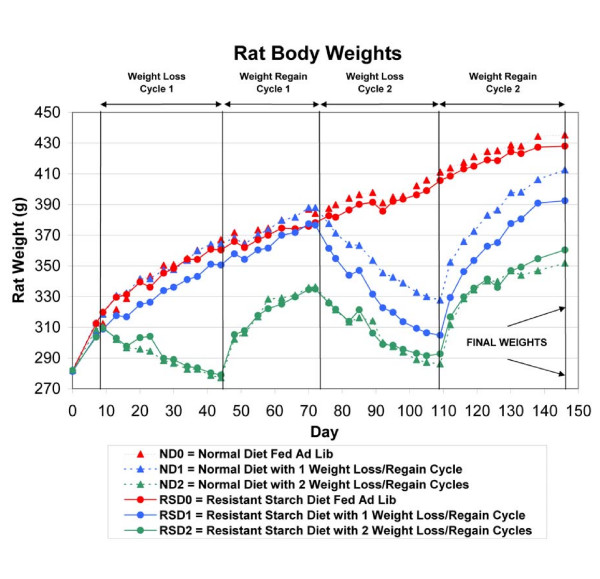
Rat body weights. Mean body weights of rats in the six treatment groups during the 21-week duration of the study. N = 84 rats. Each point in the figure is the mean for the 14 rats in each of the 6 treatment groups.